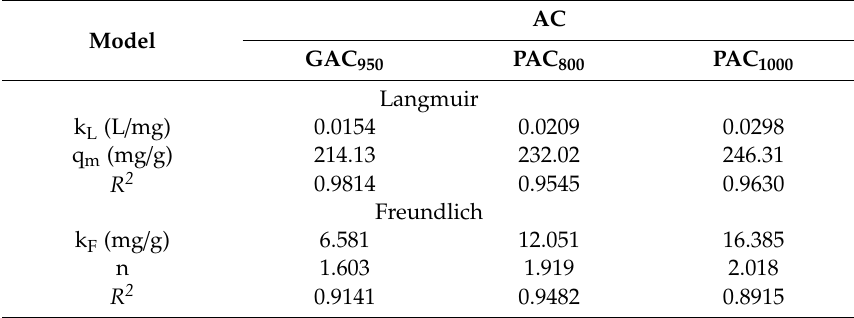
Figure 7. Fitting curves of adsorption on phenol through the Langmuir (a) and Freundlich (b) models. Table 2. Equilibrium parameters for phenol adsorption onto AC.